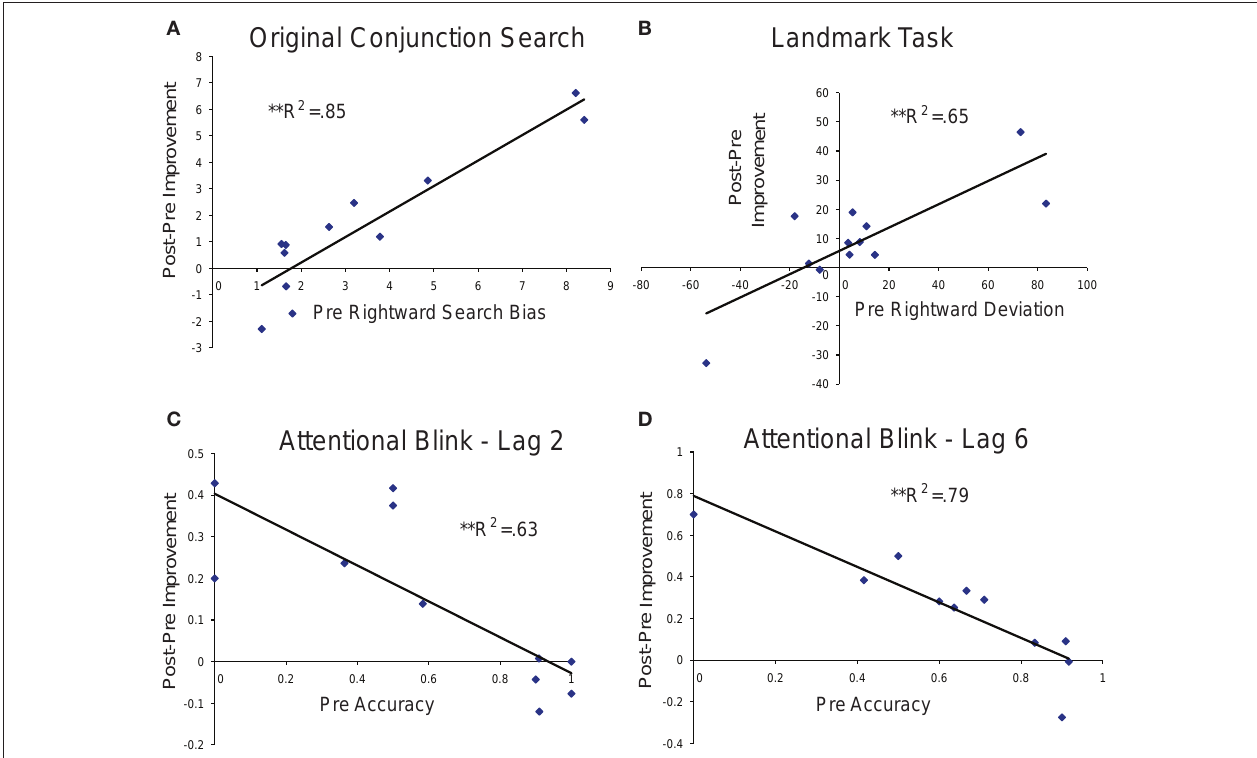
Figure 8 | Correlations between pre-training impairment and post-pre improvement scores for the original conjunction search (A) , landmark task (B) , and attentional blink task for lag 2 (C) and lag 6 (D).